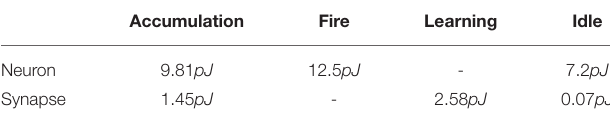
TABLE 1 | Energy estimate per spike for mrDANNA. Accumulation Fire Learning Idle